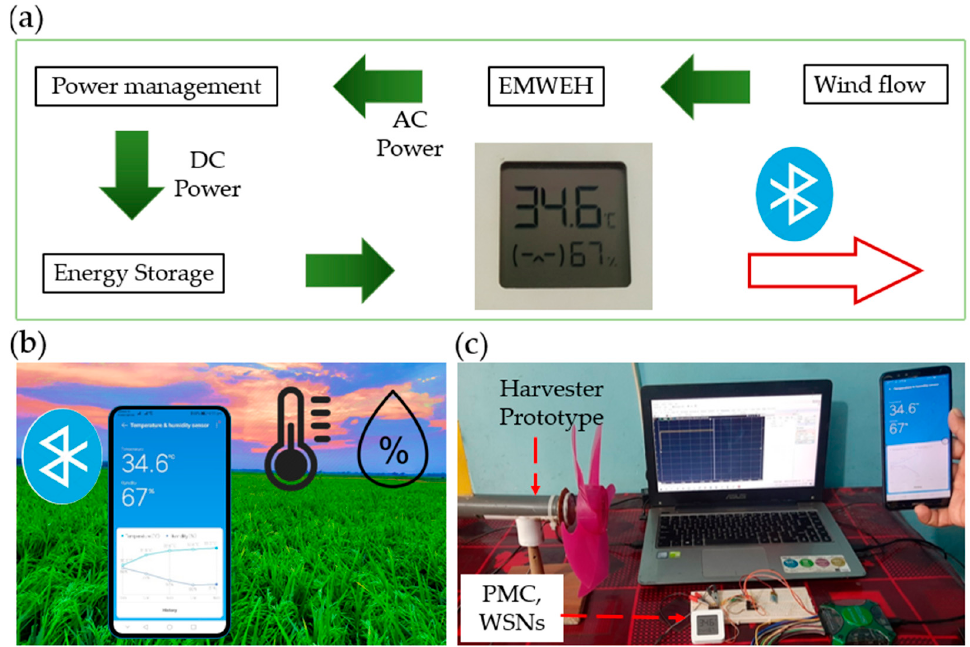
Figure 10. ( a ) Schematic of the system-level demonstration of the EMWEH, ( b ) conceptual illustration of real-time environmental monitoring of an agricultural field using smartphone, and ( c ) photograph of the experimental setup for remote environmental monitoring.